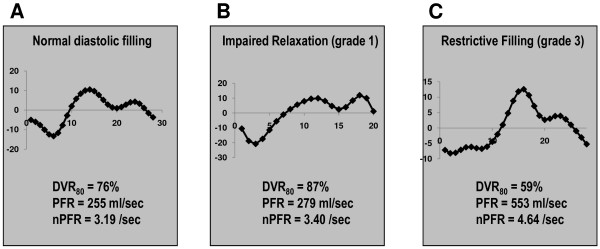
Representative Filling Profiles. Representative E:A profiles generated by cine-CMR for patients with normal echo-evidenced filling (A), grade 1 (B) and grade 3 (C) DD. Note E:A reversal with prolonged DVR80 for grade 1, and augmented E:A ratio with increased PFR for grade 3 DD. The x-axis represents phase and the y-axis is volume per phase.